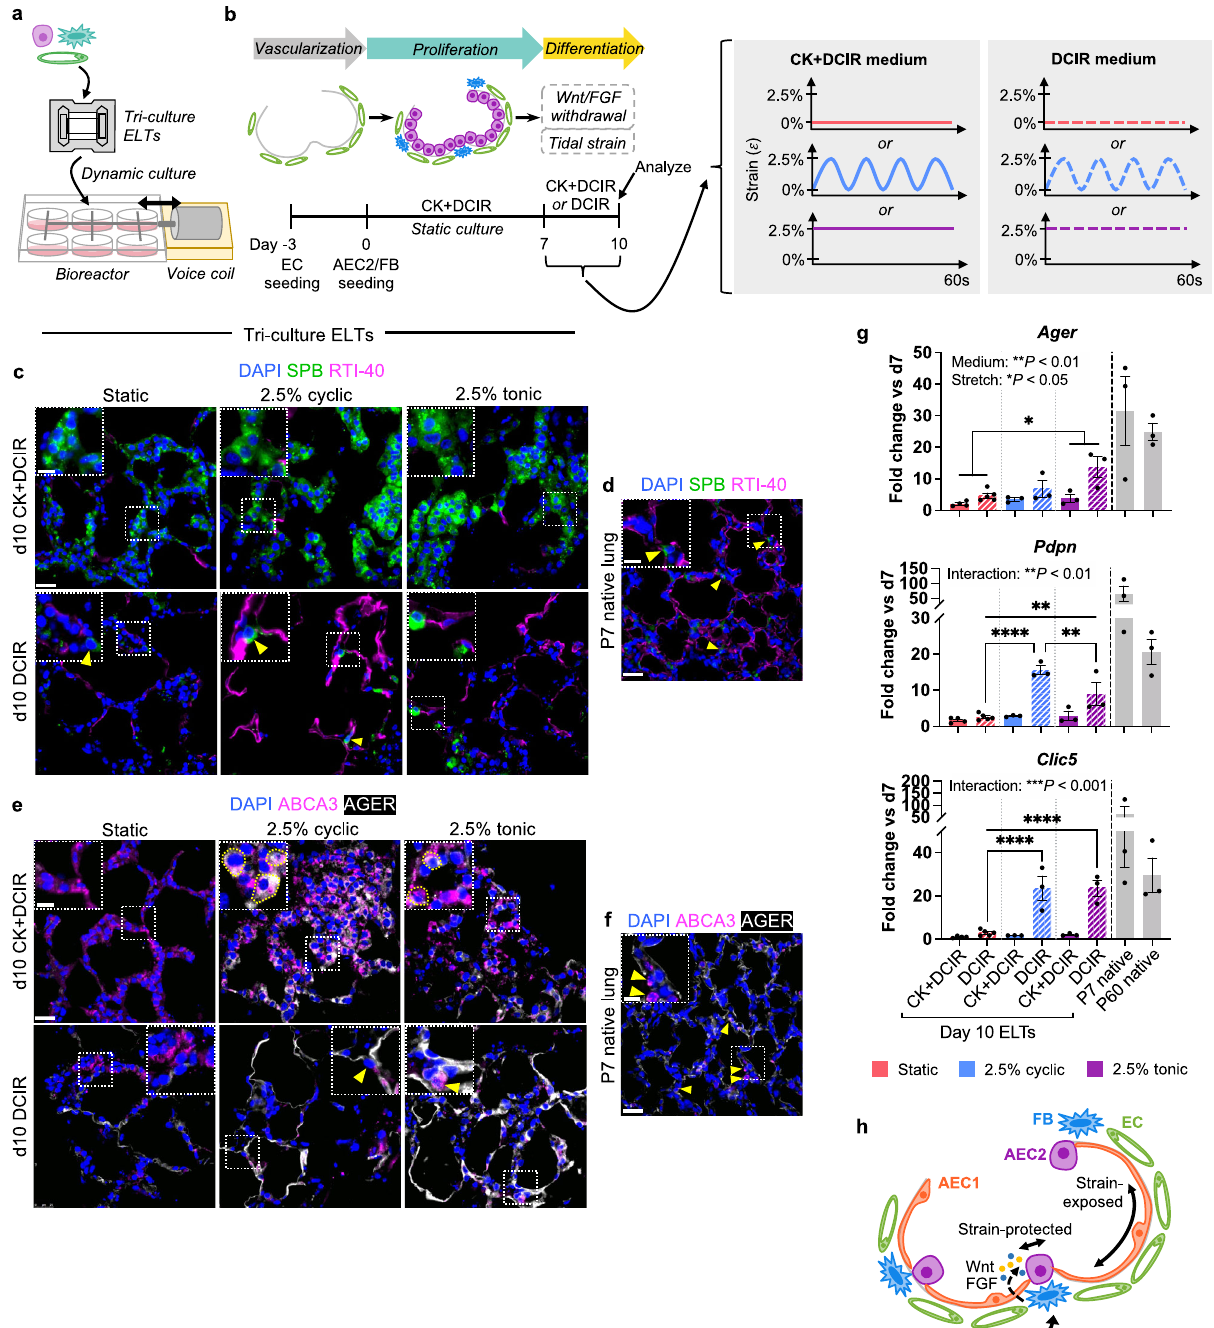
Fig. 7 Tidal strain synergizes with biochemical cues to promote the AEC1 fate in engineered lung. a Schematic of bioreactor for engineered lung tissue (ELT) dynamic culture. b Timeline of experiment examining effects of CHIR and KGF withdrawal, with or without applied tidal strain, on AEC2 differentiation in tri-culture ELTs. c – f Immunostaining for AEC2 (SPB, ABCA3) and AEC1 (RTI-40, AGER) markers in tri-culture ELTs at d10 ( c , e ) or in P7 native lung ( d , f ). Yellow arrowheads, AEC2s localized to alveolar corners. Yellow dotted outlines, AGER + / ABCA3 + cells. Scale bars: main image, 25 μ m; magni fi ed region, 10 μ m. Note that imaging parameters used for native tissues in d , f differ from those used in the corresponding ELTs, as higher exposures were generally required for native lung samples to visualize the proteins. g qRT- PCR of AEC1 gene expression in d10 ELTs, normalized to their respective d7 control tissues. Data for static controls are repeated from Fig. 6e. Native gene expression is normalized to the average expression in d7 tissues and shown for approximate comparison only. Static/CK + DCIR: n = 4; static/DCIR: n = 5; all other conditions: n = 3. Error bars: mean ± SEM. Text indicates signi fi cance by two-way ANOVA for medium main effect ( “ medium ” ), stretch main effect ( “ stretch ” ), and interaction between medium/stretch ( “ interaction ” ). P values for annotated pairwise comparisons were calculated via Holm-Sidak ’ s multiple comparisons tests. * P < 0.05, ** P < 0.01, **** P < 0.0001. h Proposed role for Wnt/FGF and tidal strain in regulating epithelial fate within the